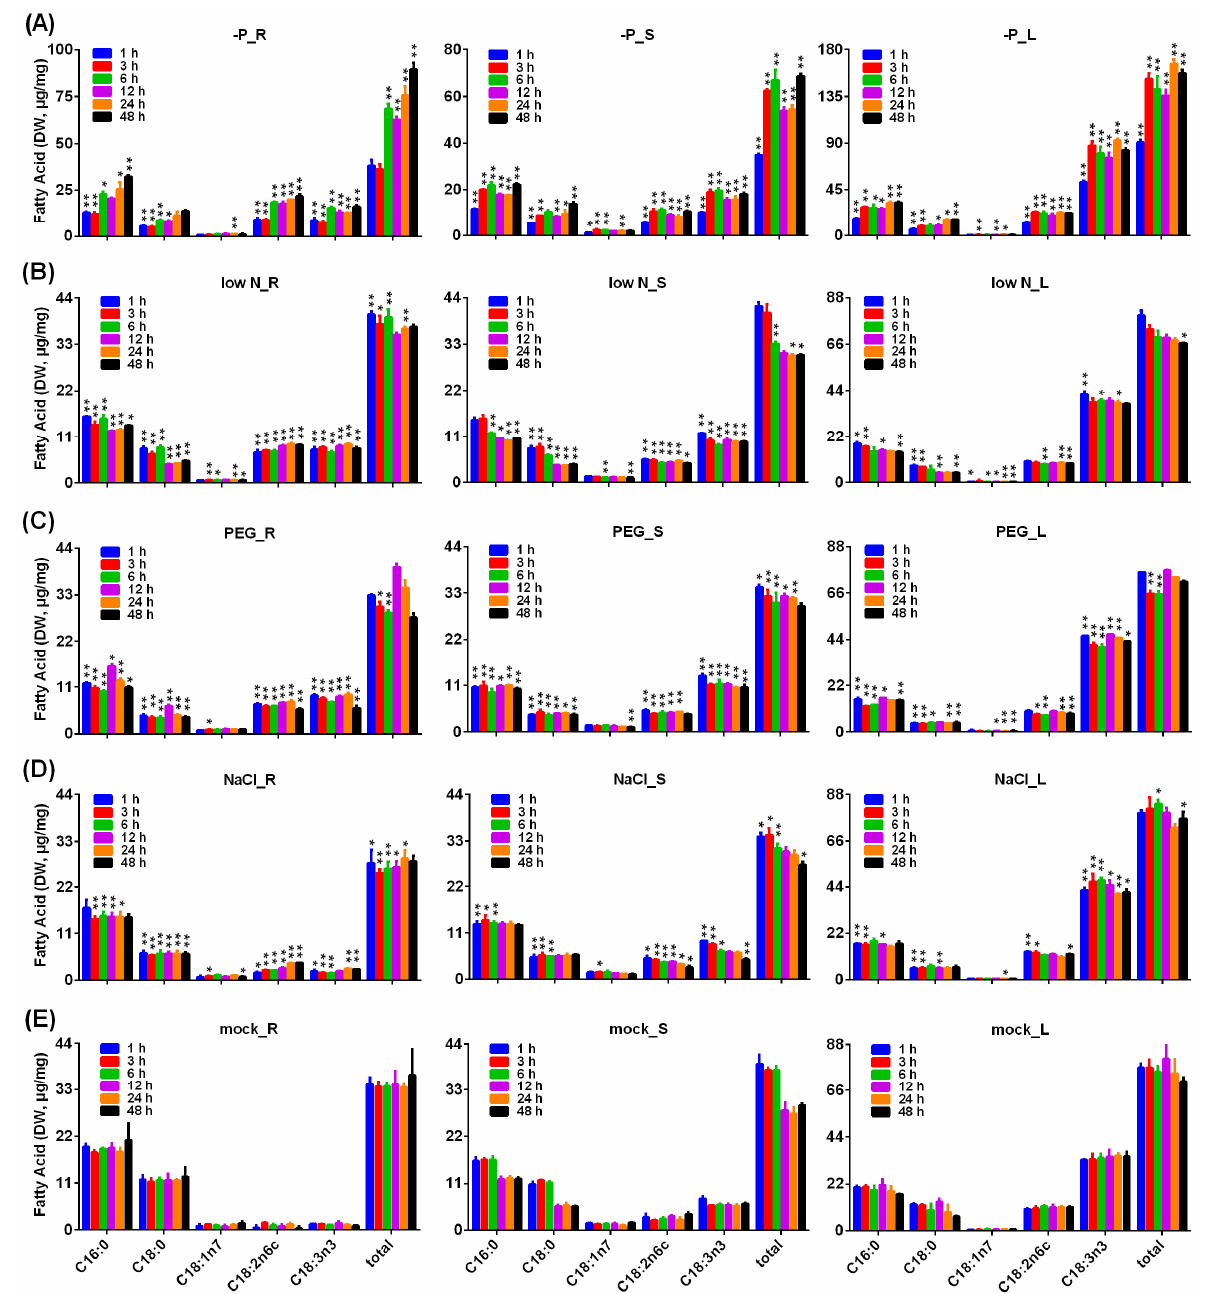
Figure 8. Main fatty acid content in roots, stems and leaves under abiotic stresses. ( A ) Pi-deficient treatment (-P); ( B ) Low nitrogen treatment (low N). ( C ) Dehydration treatment (PEG); ( D ) Salt treatment (NaCl); ( E ) Mock. For dehydration and salt stress treatments, six-week-old seedlings of B. napus were grown hydroponically in solution containing 15% ( w / v ) PEG6000 and 150 mM NaCl plus 1/2 Hoagland solution. In the Pi-deficient treatment, KH 2 PO 4 in 1/2 Hoagland solution was replaced by equimolar amounts of KCl. In the low nitrogen treatment, KNO 3 in 1/2 Hoagland solution was replaced by equimolar amounts of KCl. Seedlings grown in 1/2 Hoagland solution for various periods of time were used as the mock. The FA content was quantified by GC–MS with heptadecanoic acid (C17:0) as an internal standard. The data represent averages of three replicates ± SD. Asterisks indicate the fatty acid content with a significant difference from those in the mock (* p < 0.05; ** p < 0.01).